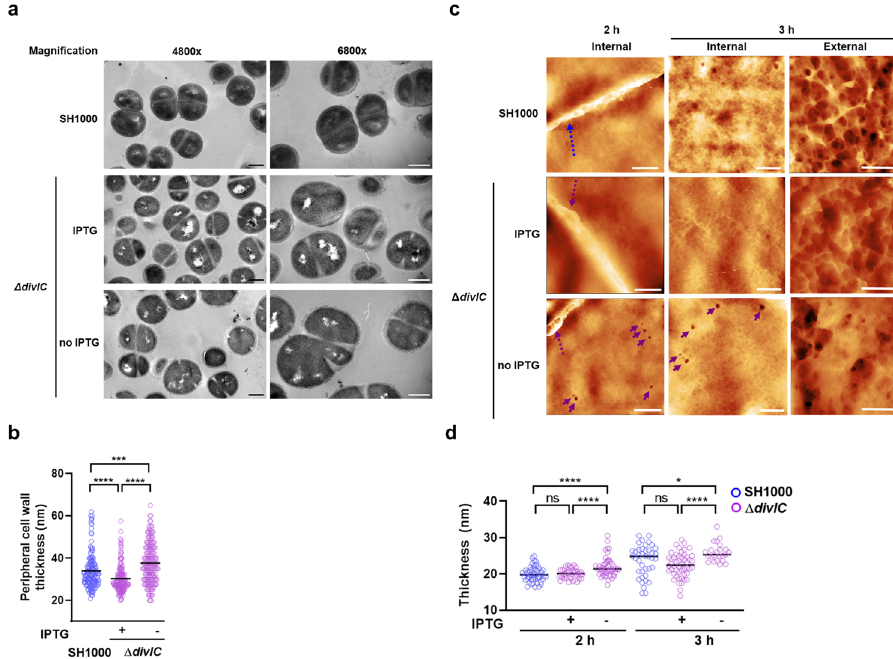
Fig. 3 DivIC regulates the architecture of the cell wall. a TEM of SH1000 and Δ divIC (SJF5450) grown for 2 h with or without IPTG. Scale bars 0.5 μ m. b Measurements of peripheral cell wall thickness from TEM images. n = 150 cells per sample, P -values were determined by Mann – Whitney U -tests (**** P < 0.0001; *** P < 0.0005). c AFM of the internal and external structures of cell walls from SH1000 and Δ divIC cells grown for 2 and 3 h in the presence and absence of IPTG. 2 h samples show piecrust development (dotted arrows) at the internal surface (scale bars, 100 nm, Z scales: 76 nm (SH1000), 73 nm ( Δ divIC IPTG), 30 nm ( Δ divIC no IPTG)). 3 h samples highlight internal (scale bars 50 nm, Z scales: 5.4 nm (SH1000), 6.3 nm ( Δ divIC IPTG), 15 nm ( Δ divIC no IPTG)) and external (scale bars 100 nm, Z scales: 40 nm (SH1000), 22 nm ( Δ divIC IPTG), 60.5 nm ( Δ divIC no IPTG)) architectural features (3 h). Arrows show deeper pores. d Cell thickness of single layer cell walls in air. Values were extracted from the AFM images using the 1D height distribution fi tting method in Gwyddion. n (left to right) = 50, 40, 48, 40, 50, 23. P -values were determined by unpaired two-tailed t- test with Welch ’ s corrections (**** P < 0.0001; * P <